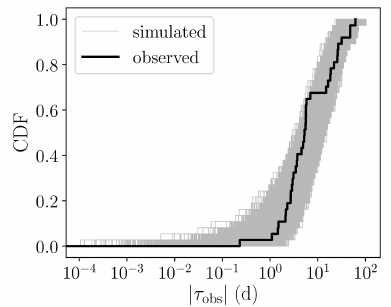
Figure 4. CDFs of the time lags τ obs between the EVPA rotations and peak moments of the closest γ -ray flares for the main sample rotators. The black line represents observed time lags, and the thin grey lines represent 10 4 simulated values for the whole sample of rotations. Based on data from [46].